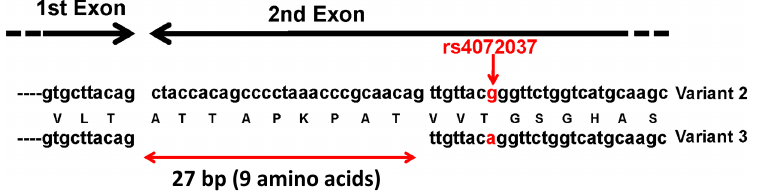
27 bp (9 amino acids)